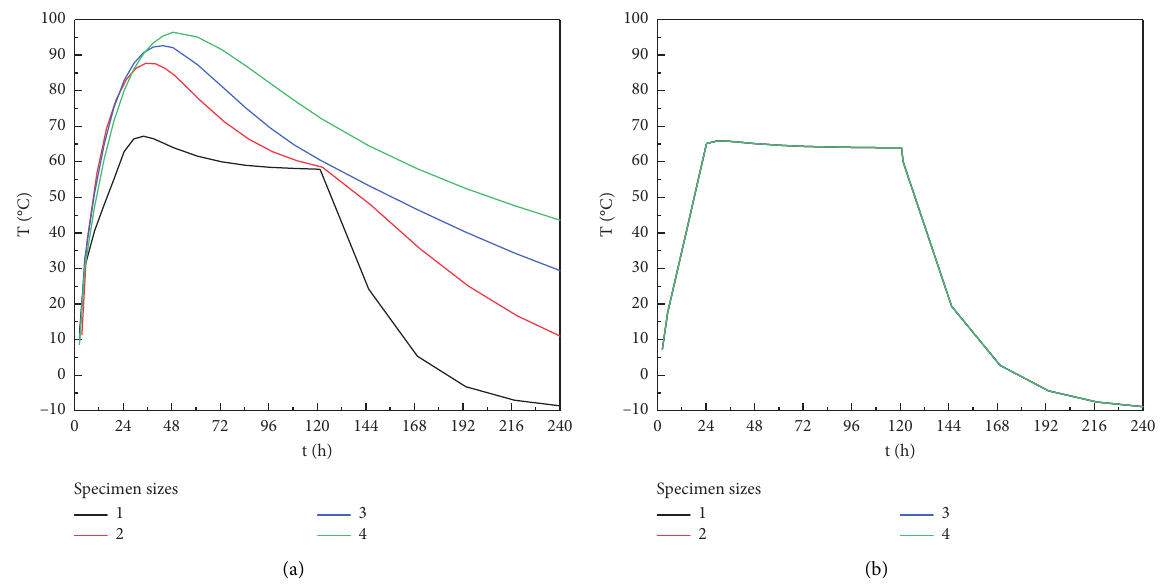
Figure 11: Change in concrete temperature according to specimen size at (a) T3 and (b)